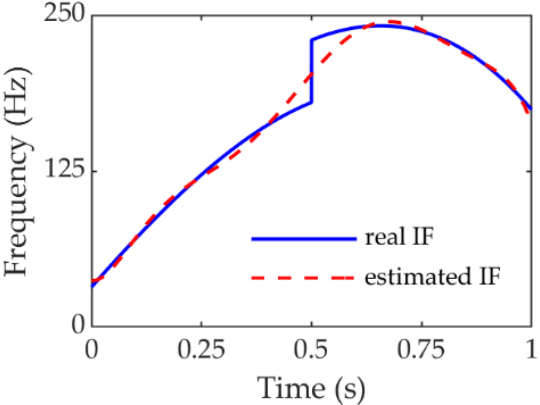
Figure 14. The estimated IF compared with the real IF of the piecewise signal.